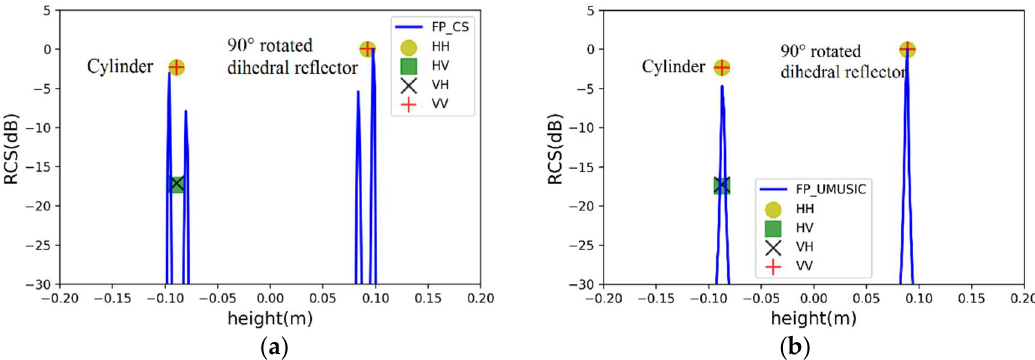
Figure 4. Estimated results of two point scatterers with a spacing of 0.18 m by ( a ) fully-polarimetric